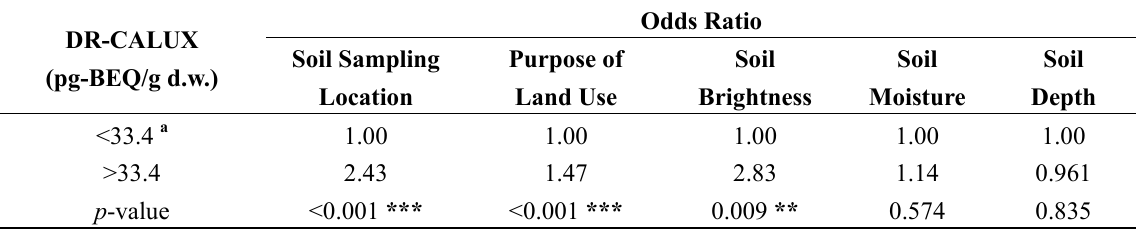
Table 2. Univariate logistic regression to obtain odds ratios of Taiwanese soil dioxin concentrations >3rd quartile (33.4 pg-BEQ/g d.w.) according to soil sampling location, land use, soil brightness, soil moisture, and soil depth (n = 662).